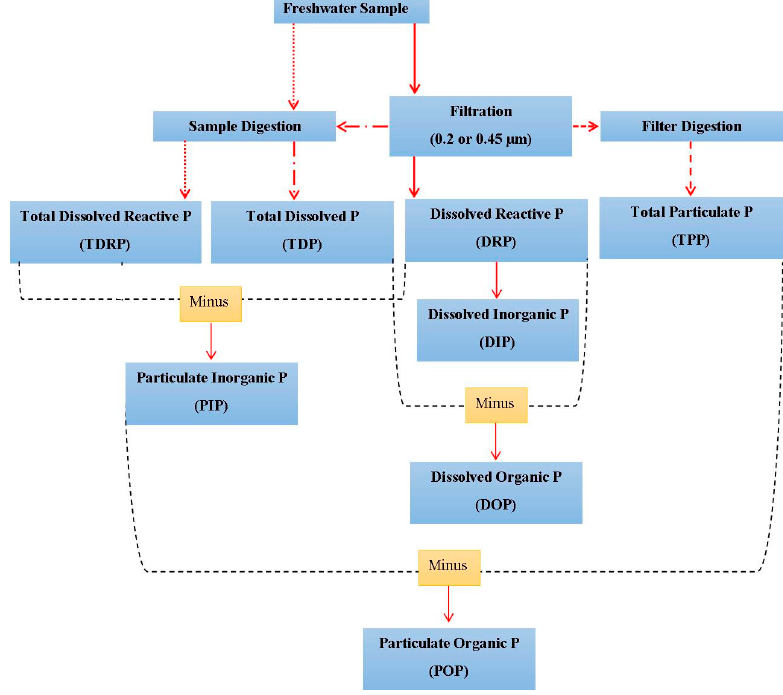
Figure 7. Determination of various organic and inorganic P fractions in freshwater samples (Adapted from Worsfold et al. [12]).